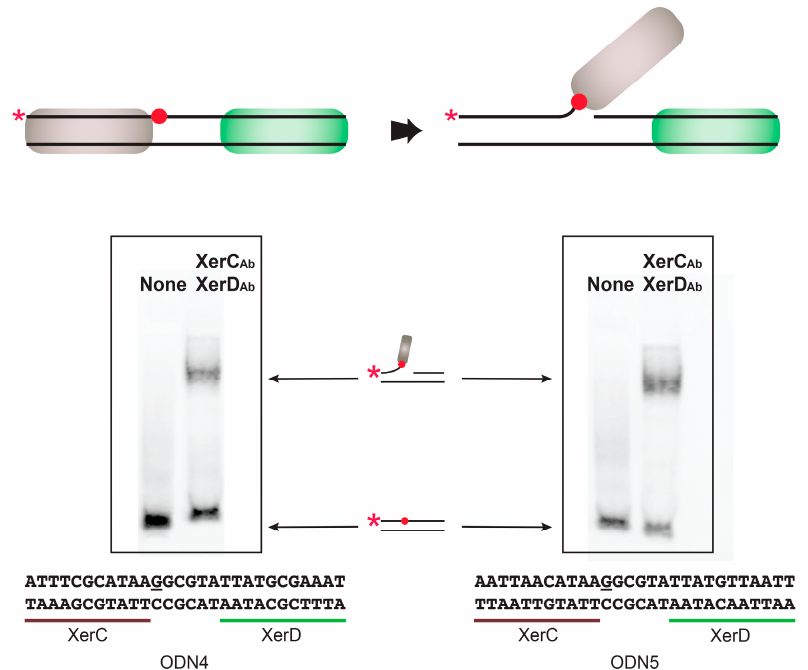
Figure 5. In vitro cleavage of the Xer recombination sites. The substrate double-stranded oligonucleotides include a phosphorothioate analog (underlined, red dot) to trap the DNA-Xer product formed after digestion and covalent attachment to the Y residue of the recombinase (top). Reactions were carried out at 37 °C for 1 h in the presence or absence of XerC Ab (brown) and XerD Ab (green). Samples were heated at 95 °C for 5 min and subjected to 1% sodium dodecyl sulfate–8% polyacrylamide gel electrophoresis. The asterisk represents the 5 ′ -end biotinylation. The bands were visualized as described in Materials and Methods.